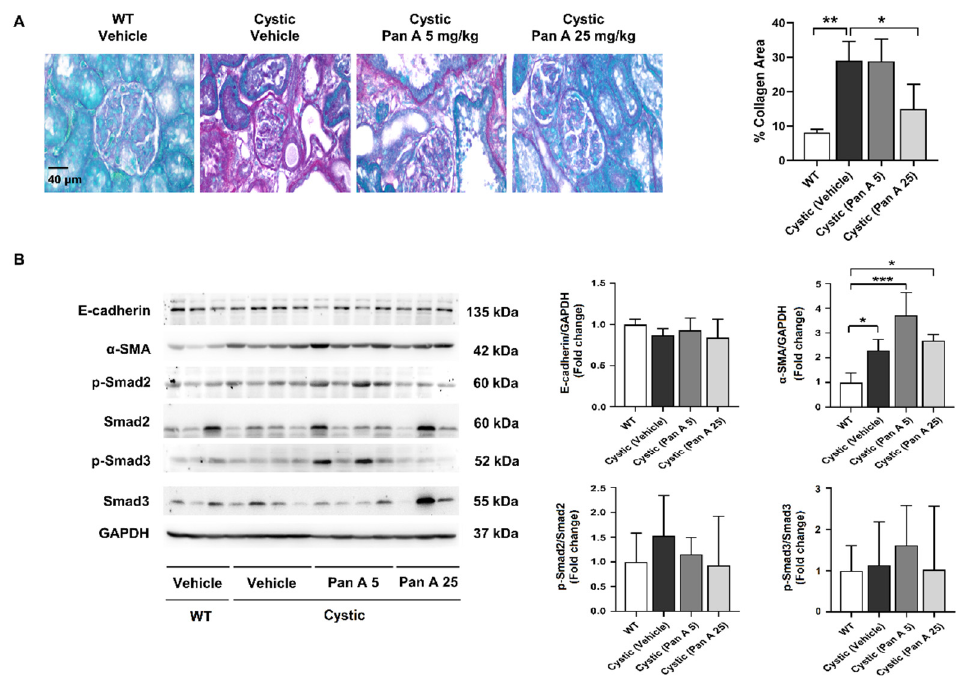
Figure 7. Effect of panduratin A on renal collagen deposition and fibrosis-related proteins in PKD rats. ( A ) Representative images of Sirius Red–stained kidney sections from wild-type (WT) and cystic (Han:SPRD) rats treated with vehicle or panduratin A (PanA) and percentage collagen area. ( B ) Representative and quantitative immunoblots for fibrosis-related proteins. Data are shown as mean ± SD, n = 3–4 rats per group, * p < 0.05, ** p < 0.01, and *** p < 0.001.